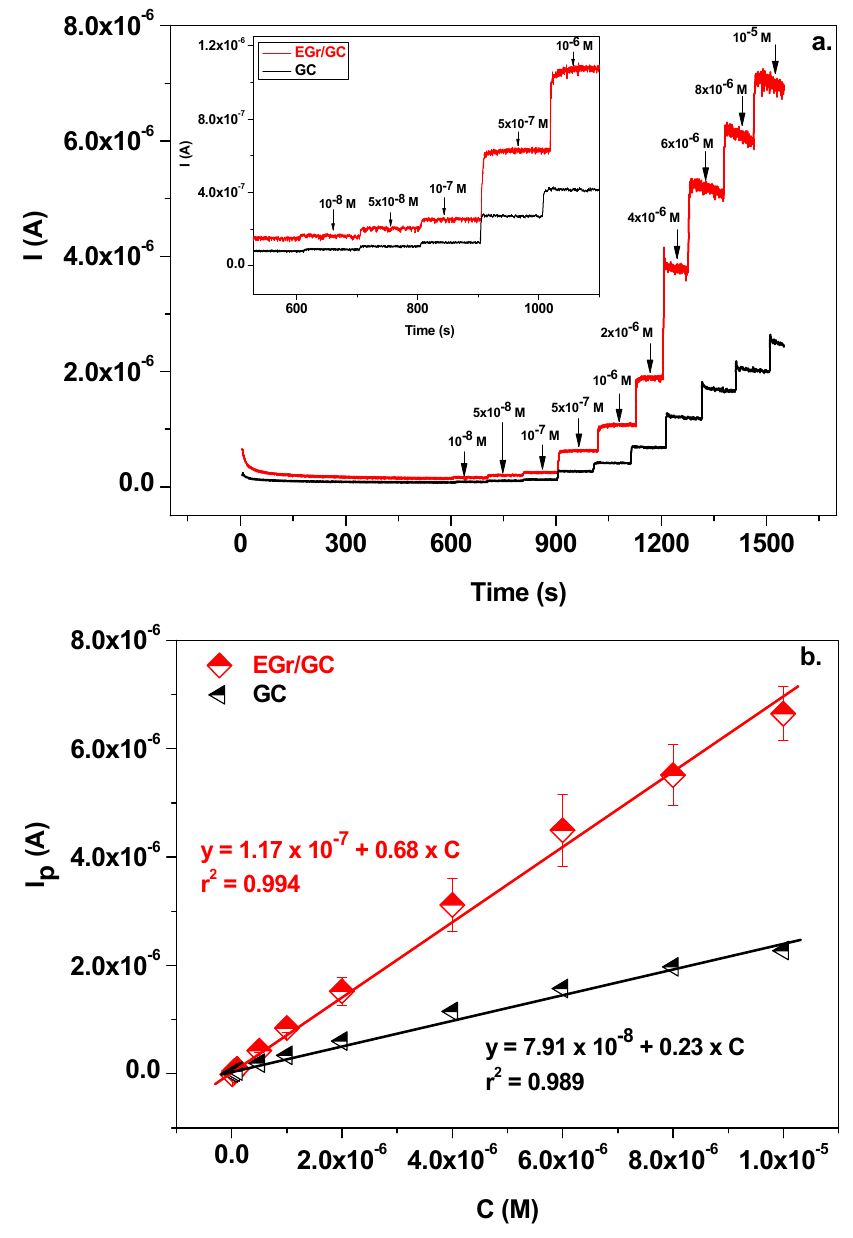
Figure 9. Amperometric curves recorded with EGr/GC (red) and GC (black) electrodes in sup- porting electrolyte of pH 5, after the addition of AZT from 10 − 4 M stock solution; the concentration range was from 10 − 8 to 10 − 5 M AZT; inset : the low concentration range, from 10 − 8 to 10 − 6 M ( a ); the corresponding calibration curves for EGr/GC (red) and GC (black) electrodes, using background subtracted signals ( b ).